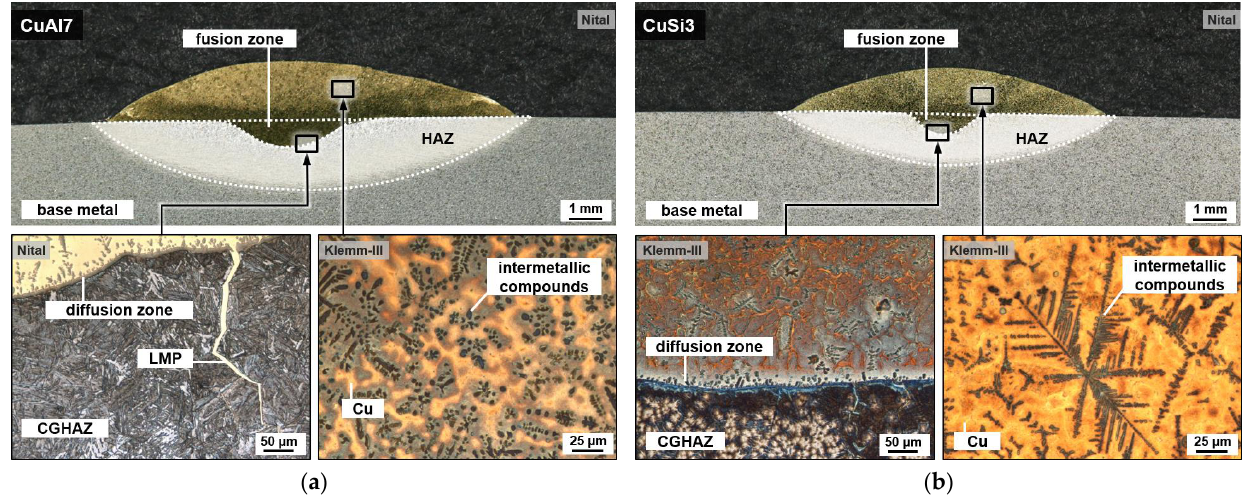
Figure 4. Microsection of an arc brazed bead on plate, etched with Nital 3% and Klemm-III; ( a ) CuAl7 filler, high heat input; ( b ) CuSi3 filler, low heat input. Table 3. Bead geometry and hydrogen